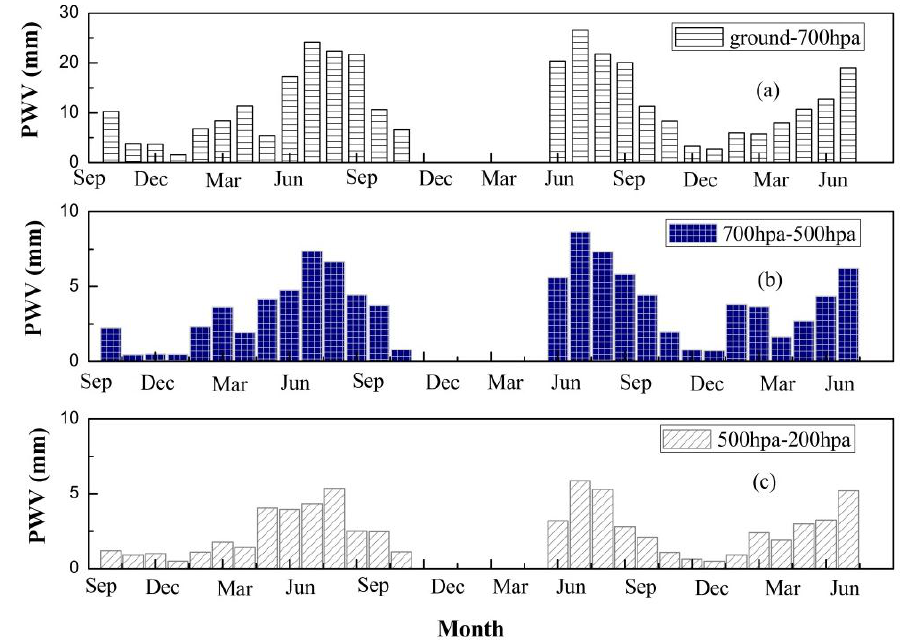
Figure 7. Seasonal variations in PWV in different layers from September 2013 to July